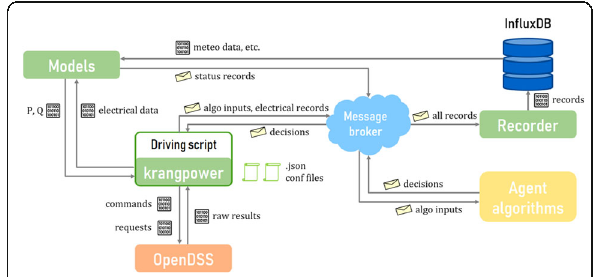
Fig. 1 (abstract P9). Scheme of the OPTISIM architecture